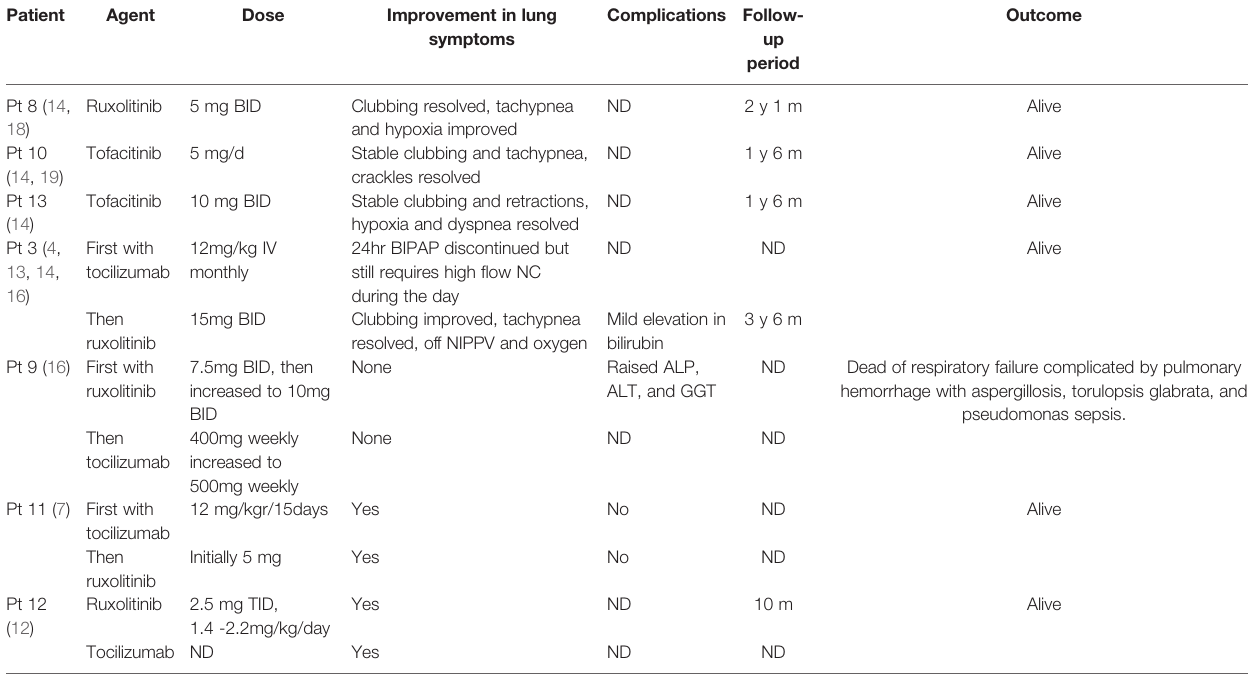
TABLE 3 | Target therapies in STAT3 GOF patients with ILD. Patient Agent